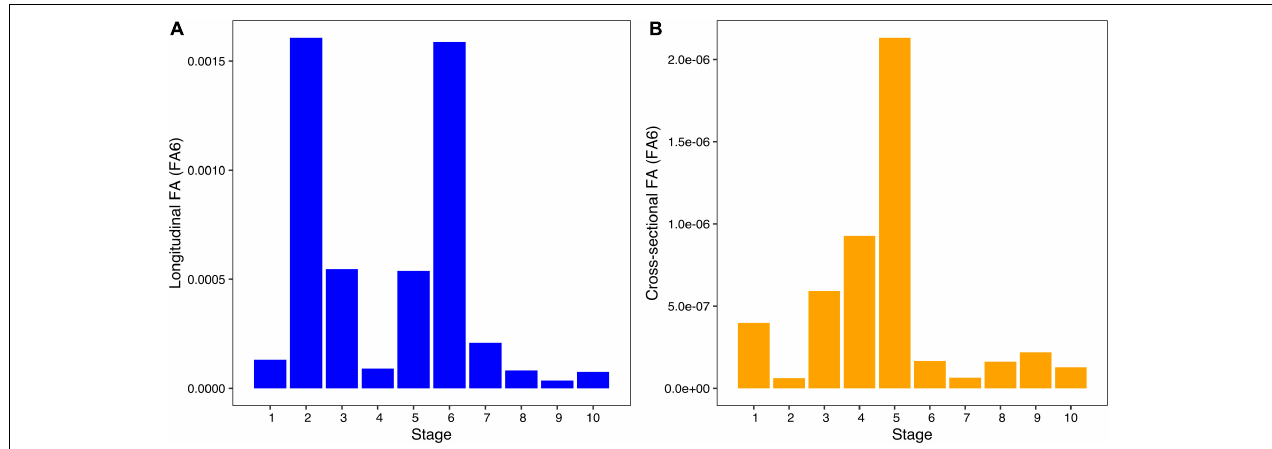
FIGURE 4 | Bar plot of per stage longitudinal (A) and cross-sectional (B) FA6 values across development. Stages 1–10 represent early to late prenatal development.